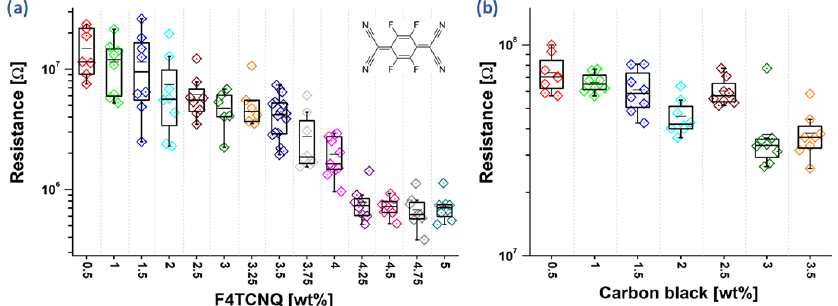
Figure 1. ( a ) Box plots of F4TCNQ-doped polyaniline sensor units, the insert shows the chemical structure of F4TCNQ; ( b ) box plot of carbon black-doped polyaniline sensor